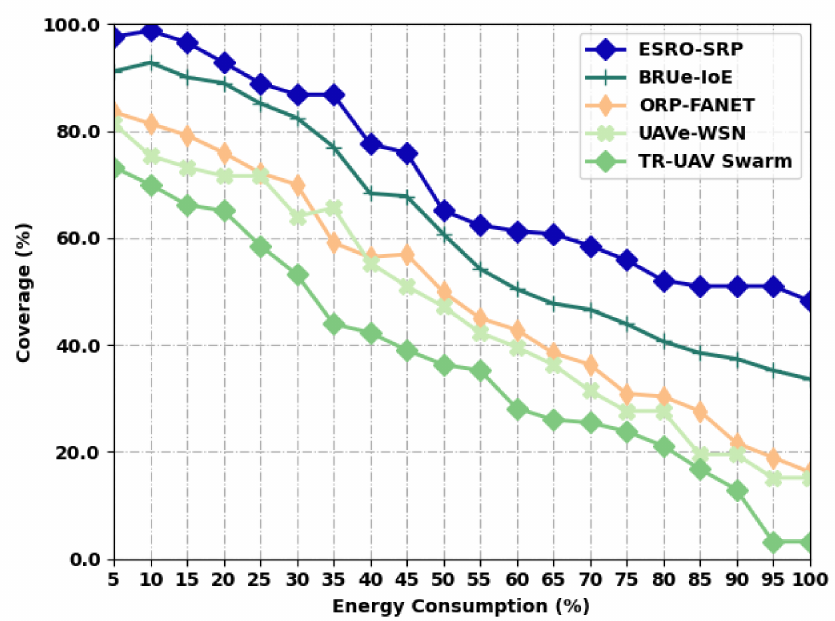
Figure 5. Coverage analysis of ESRO-SRP technique under distinct levels of energy. Table 5. Lifetime analysis of ESRO-SRP technique with existing algorithms under distinct levels of